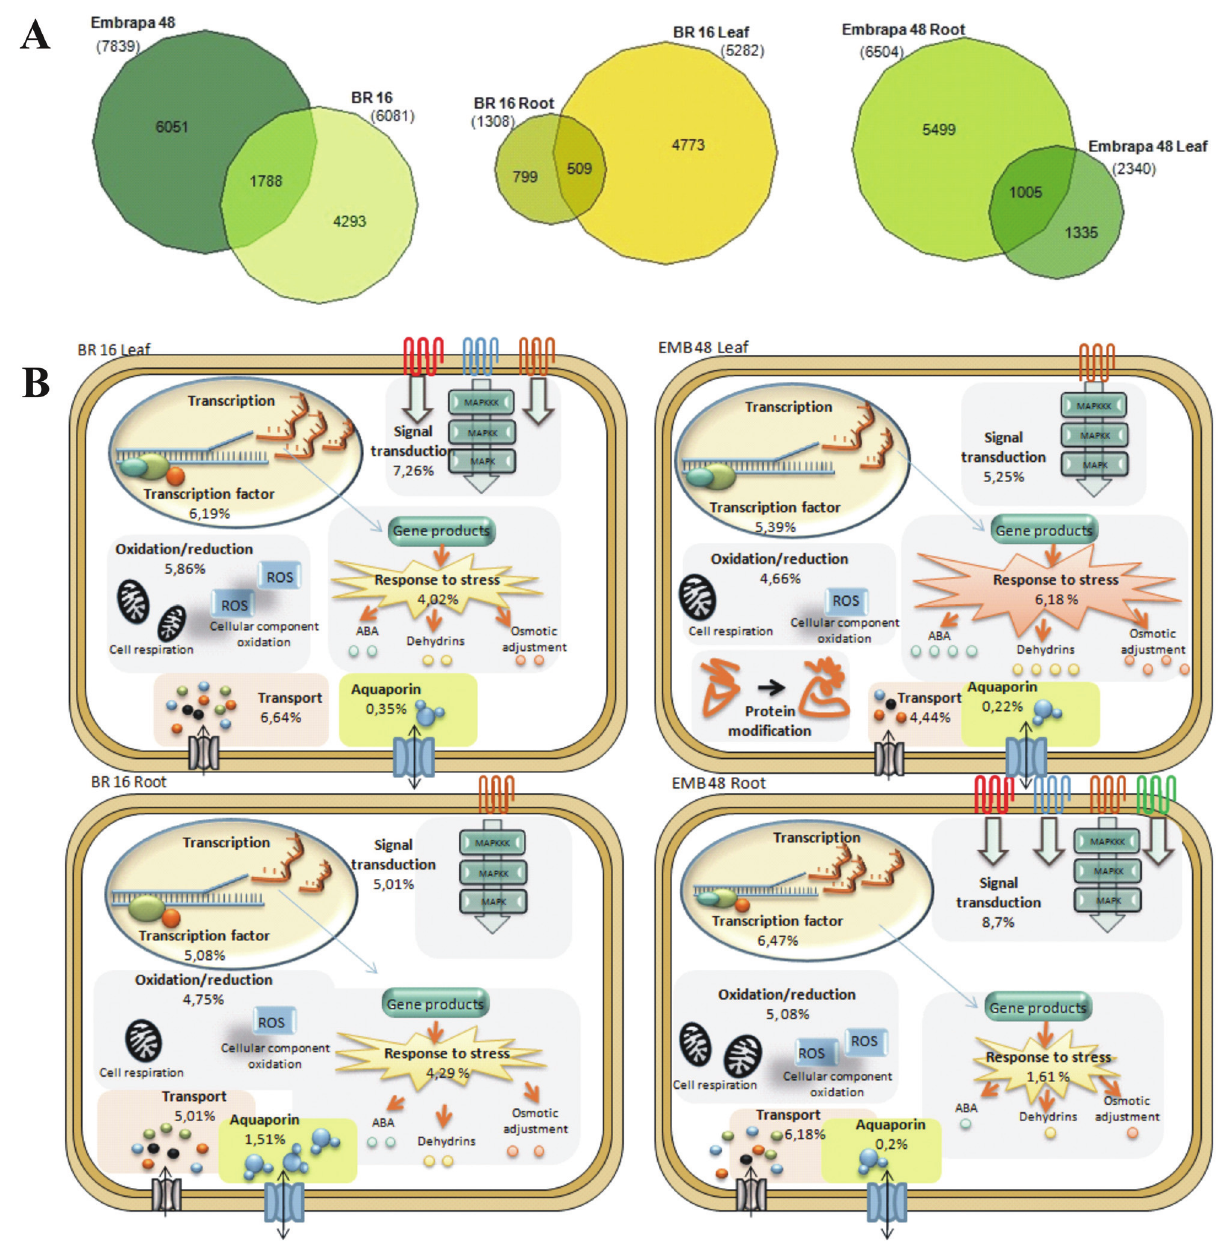
Figure 5 - Genes expressed in BR 16 and Embrapa 48 cultivars. The number of non-redundant genes identified for the cultivar/tissues is shown for each set. Subsets of genes that are shared between the sets under comparison are presented in the intersection (A). The most frequent biological processes ob- servedforeachplantandtissueareshown(B).Thepercentage(%)representsasetoftranscriptsnormalizedagainstthetotalnumberofgenesidentifiedin the respective